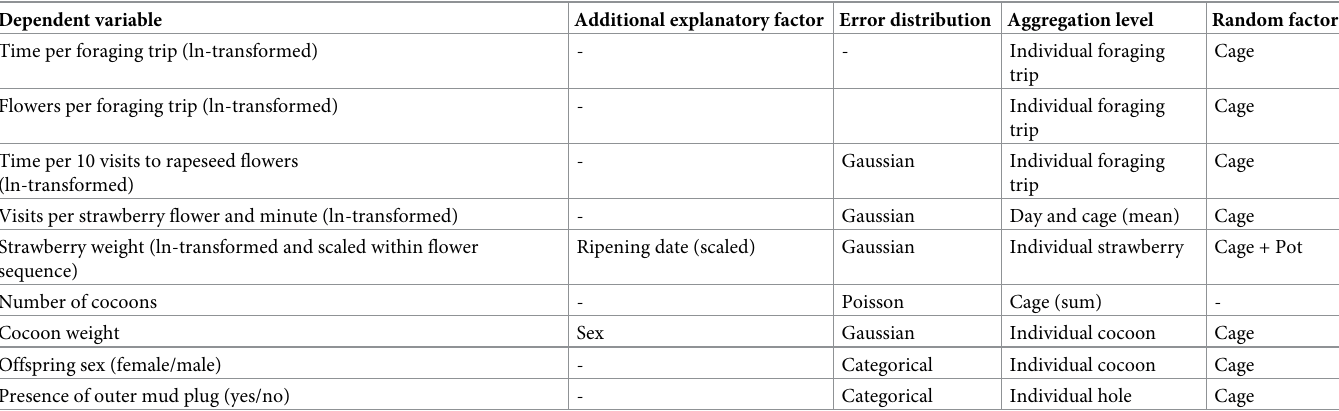
Table 3. Summary of the statistical